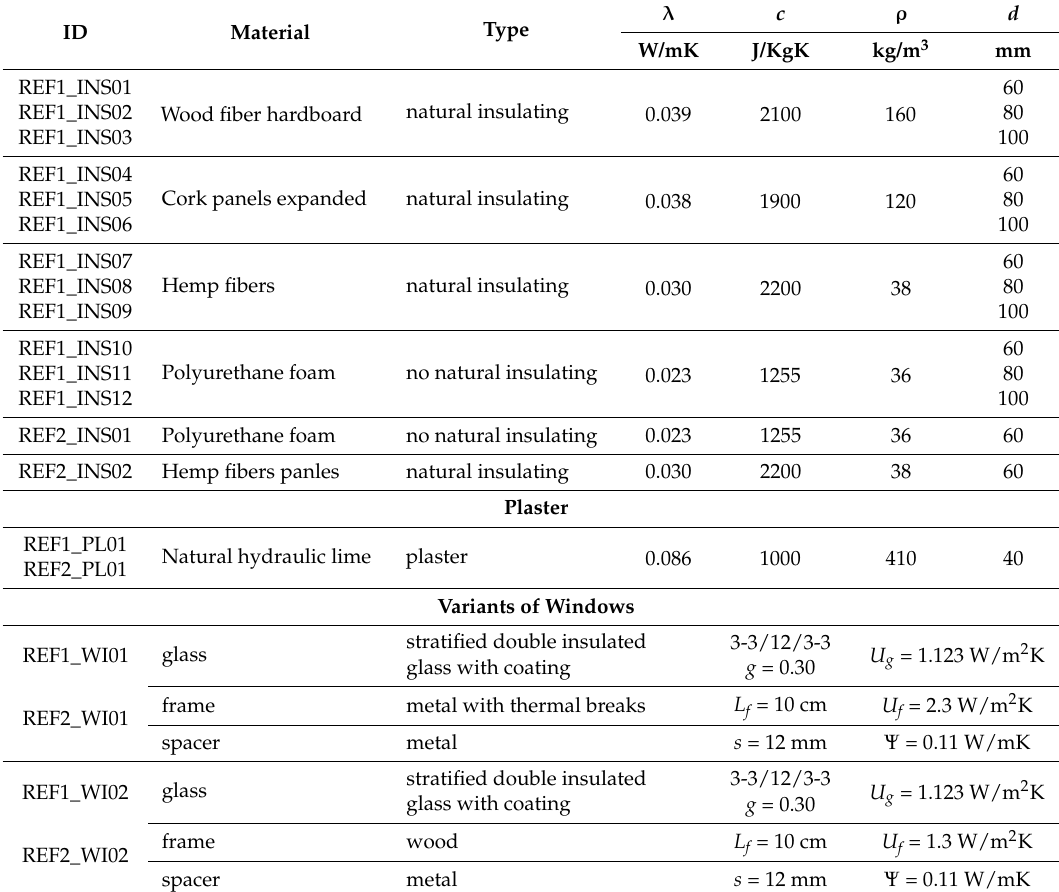
Table 4. Variants of insulating for external walls and variants of windows of the reference